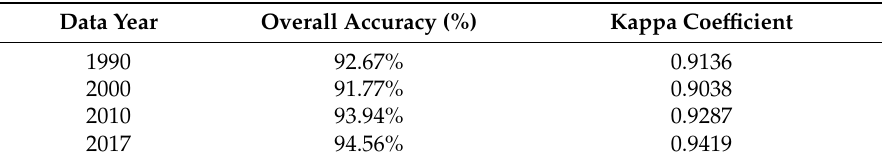
Table 1. The accuracy result of the land use / cover maps in the study